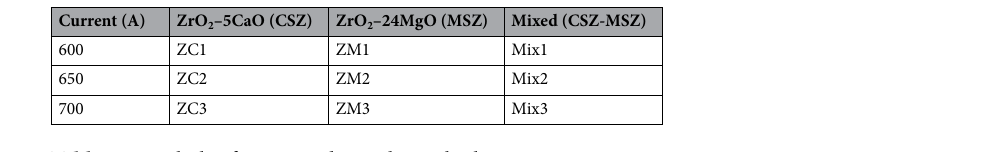
Table 4. Symbols of top coated samples with plasma